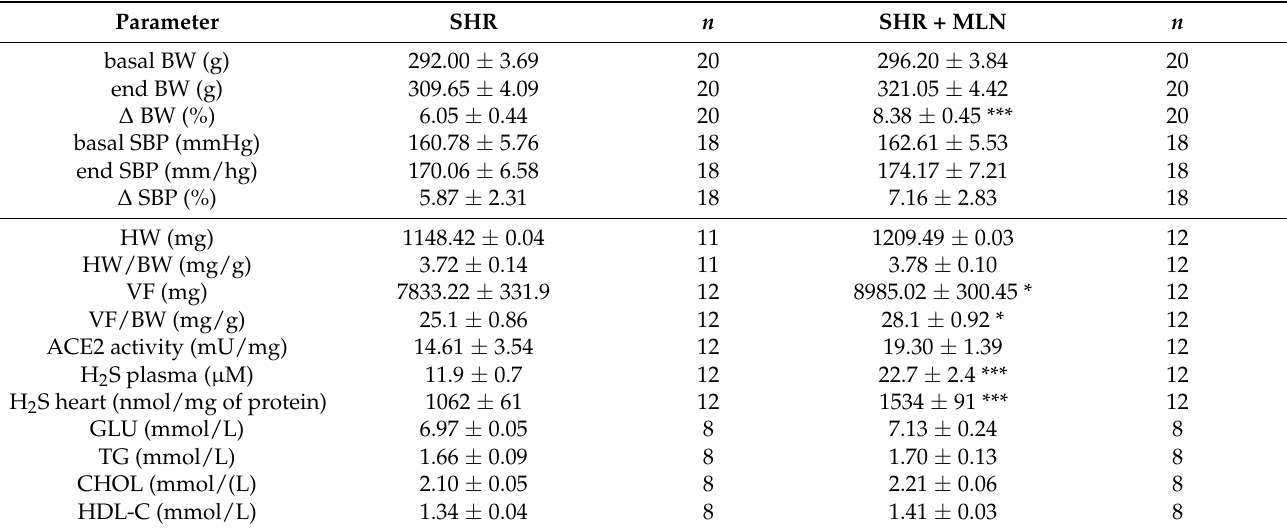
Table 1. General characteristics of experimental animals.